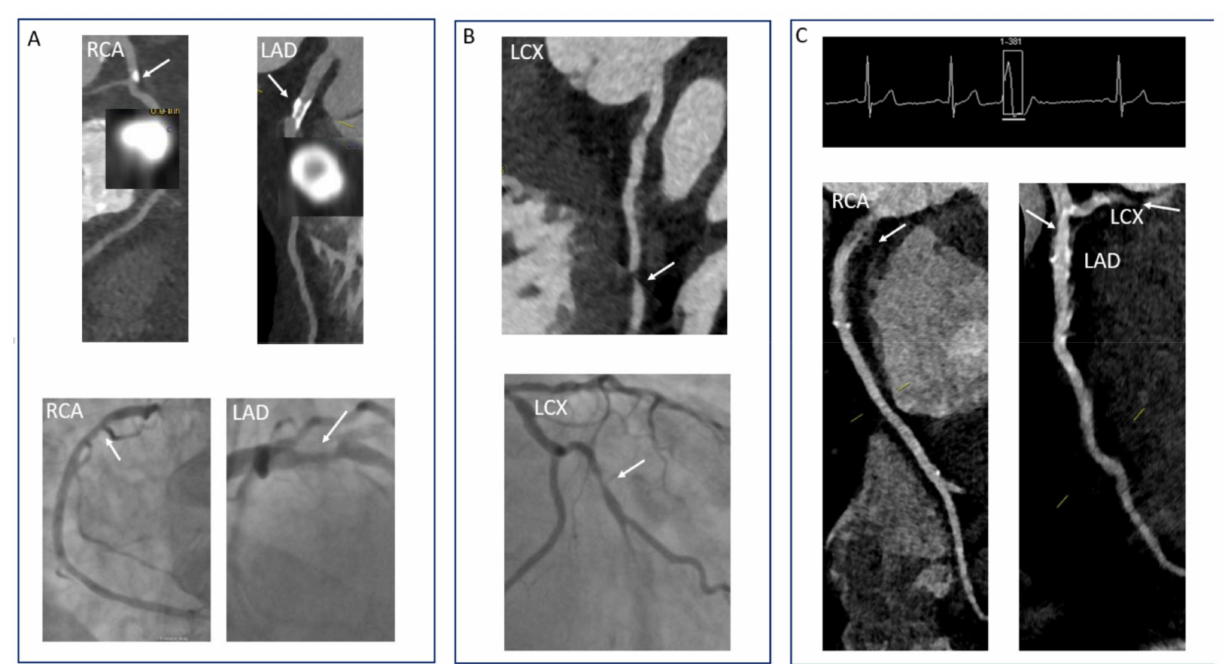
Figure 6. Pitfalls in the interpretation of CCTA images. ( A ) Severe localized calcification can hamper an accurate assessment of the level of stenosis. In this case, CCTA overestimated the stenosis in the RCA and underestimated the stenosis in the LAD (images from ICA for comparison). ( B ) Step or stitching artefacts can impede the accurate assessment of the vessel, especially if a stenosis is located at the level of the step. In this case, a moderate stenosis of the LCX was difficult to evaluate (ICA images for comparison). ( C ) An extrasystole at the moment of the acquisition can make segments of the coronary arteries uninterpretable when using a high-pitch